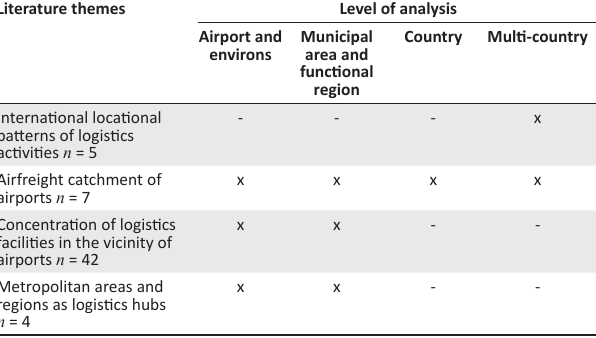
TABLE 2: A summary of the